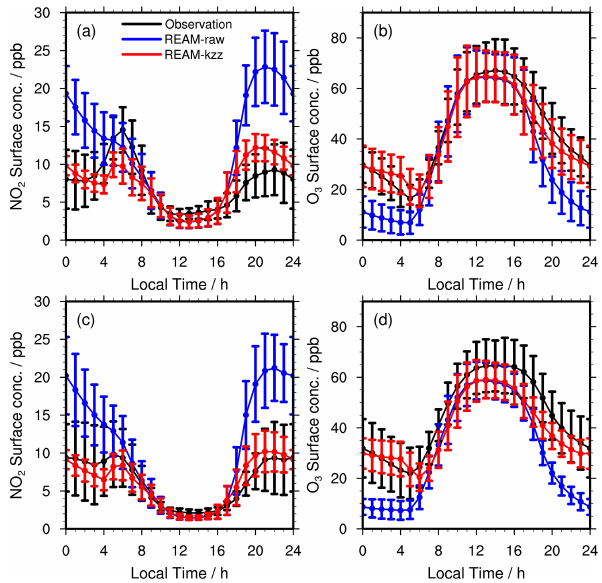
Figure 5. Diurnal cycles of surface (a,c) NO 2 and (b,d) O 3 concentrations on (a,b) weekdays and (c,d) weekends during the DISCOVER-AQ campaign in the DISCOVER-AQ region (the 36km grid cells over the 11 inland Pandora sites shown in Fig. 1). Black lines denote the mean observations from all the 11 NO 2 sur- face monitoring sites and 19 O 3 surface sites during the campaign (Fig. 1), as mentioned in Sect. 2.5. “REAM-raw” (blue lines) de- notes the coincident 36km REAM simulation results with WRF- YSU-simulated k zz data, and “REAM-kzz” (red lines) is the coin- cident 36km REAM simulation results with updated k zz data. See the main text for details. Vertical bars denote corresponding stan- dard